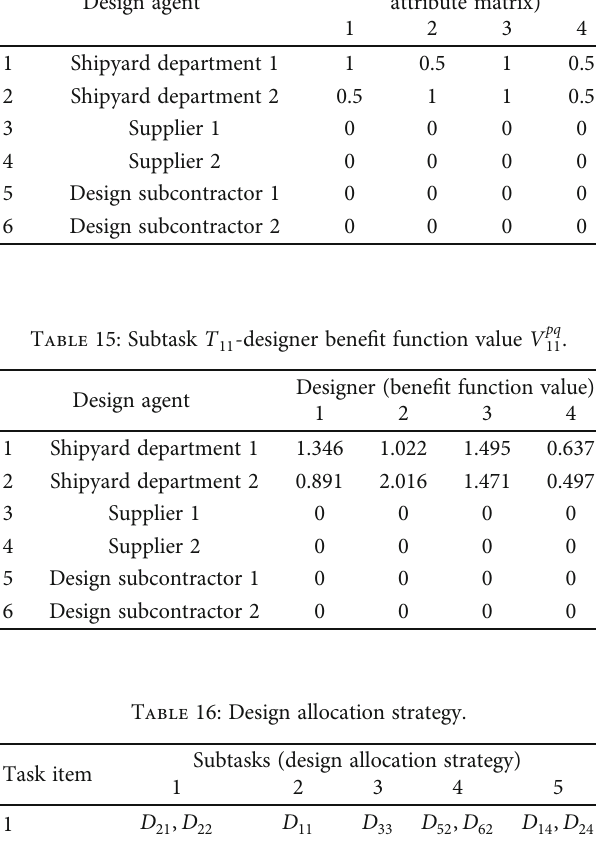
Table 14: Designer on subtask T